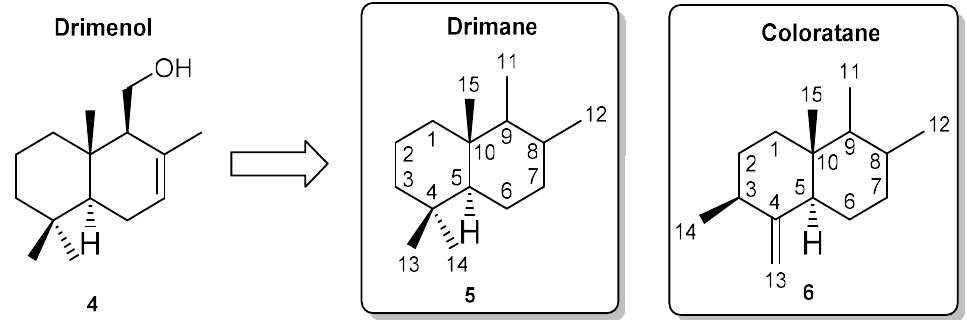
Figure 2. Scaffold of drimane and coloratane sesquiterpenoids.